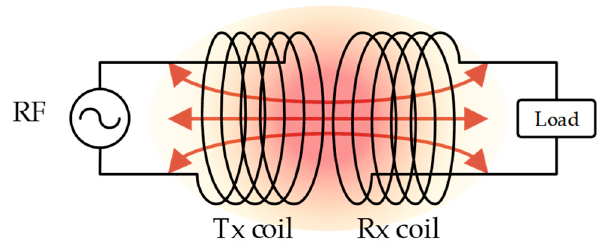
Figure 1. Inductive wireless power transfer system.